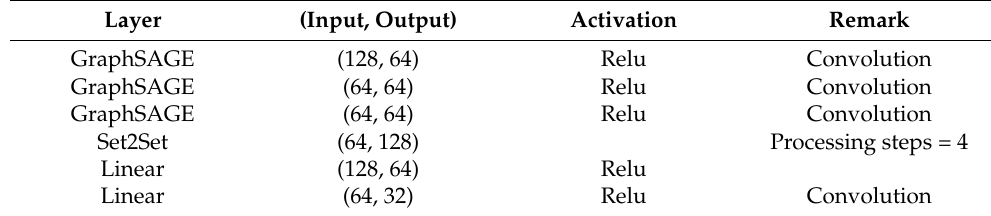
Table 2. Parameters of similarity model.